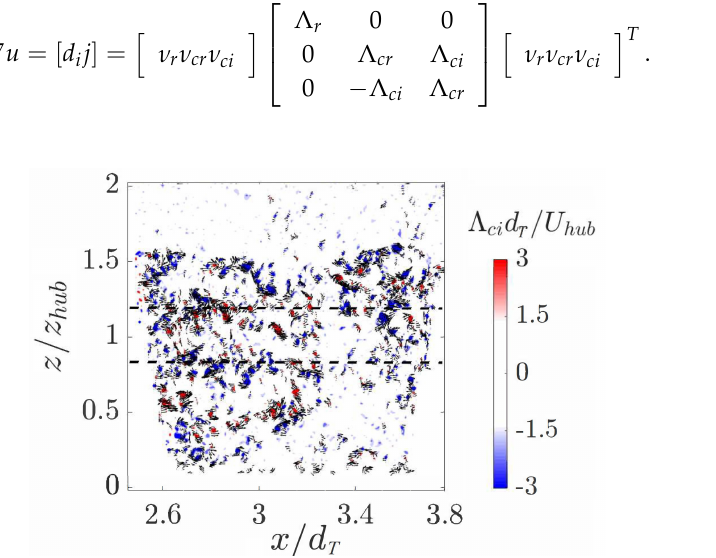
Figure 3. Instantaneous swirling strength Λ ci d T / U hub in the near wake of the L / R = 0.6 truncated rotor. The horizontal-dashed lines indicate the inner